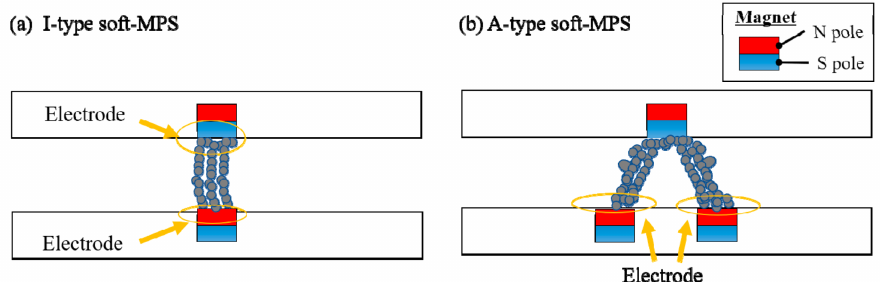
Figure 1. Magnetic field orientation of the ferromagnetic powder for two different types of magnetic resistive tactile sensors: ( a ) I-type soft-magnetic powdery sensors (MPS). One of the electrodes is set on the plate to which the external force is applied. ( b ) A-type soft-MPS. All electrodes are set on the bottom